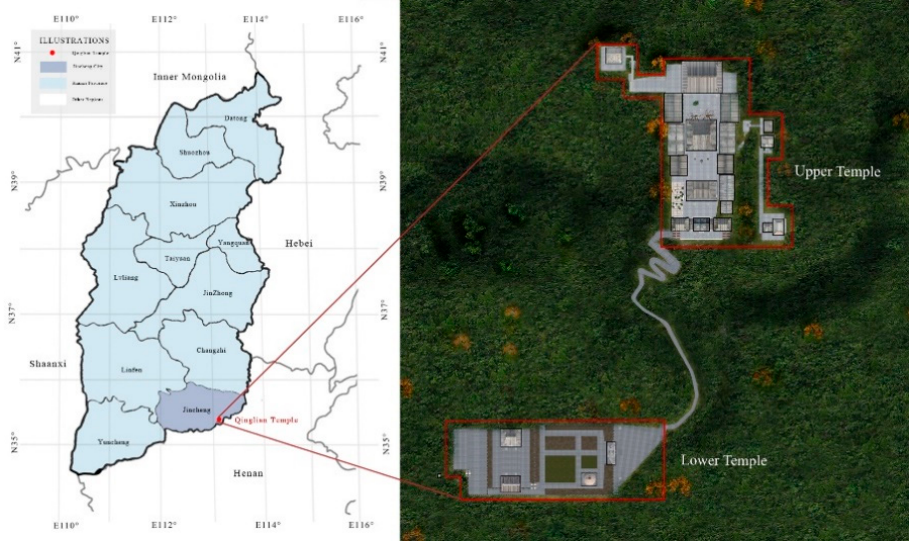
Figure 6. Location of Qinglian